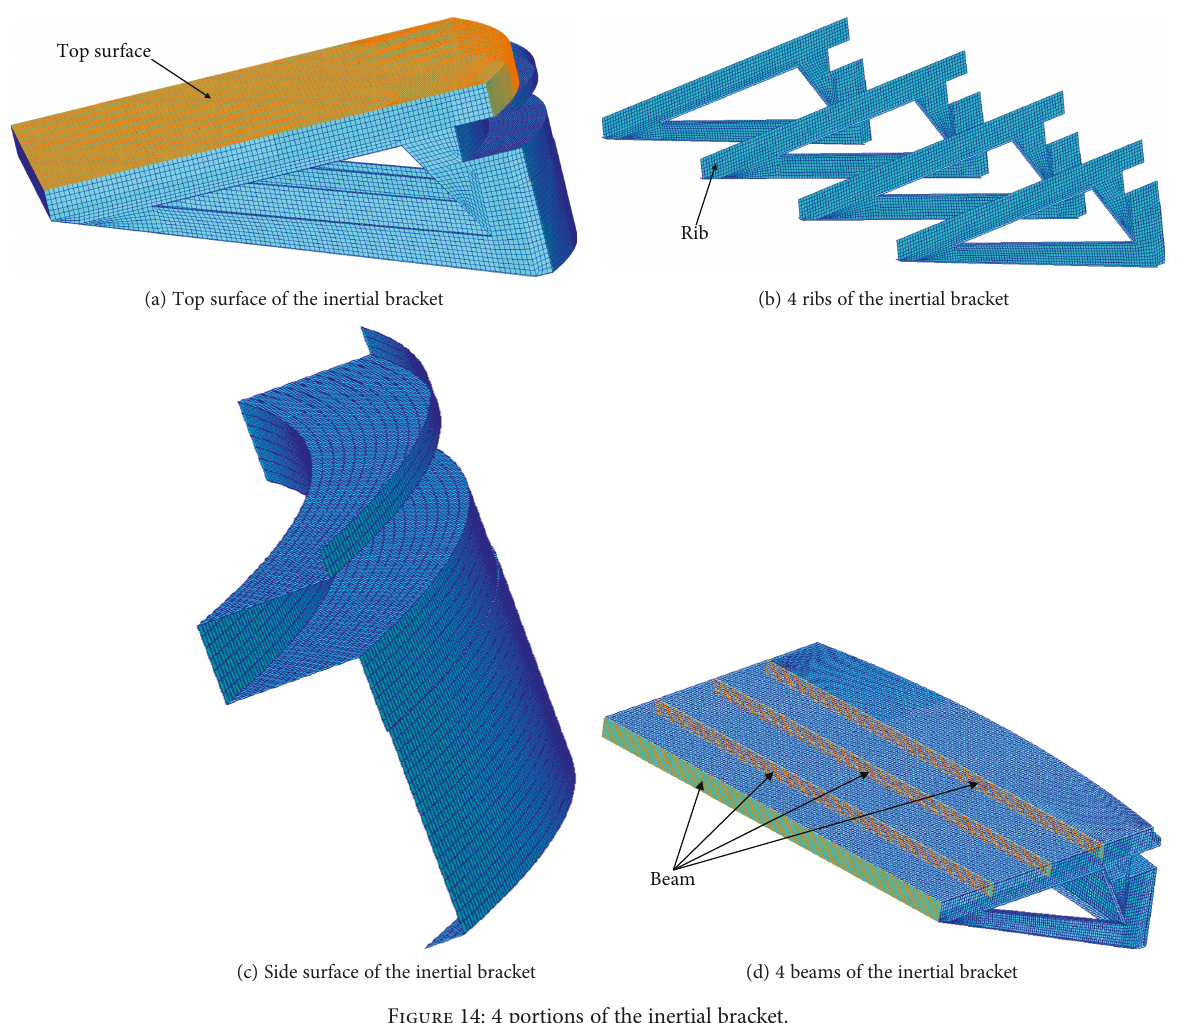
Figure 14: 4 portions of the inertial bracket.